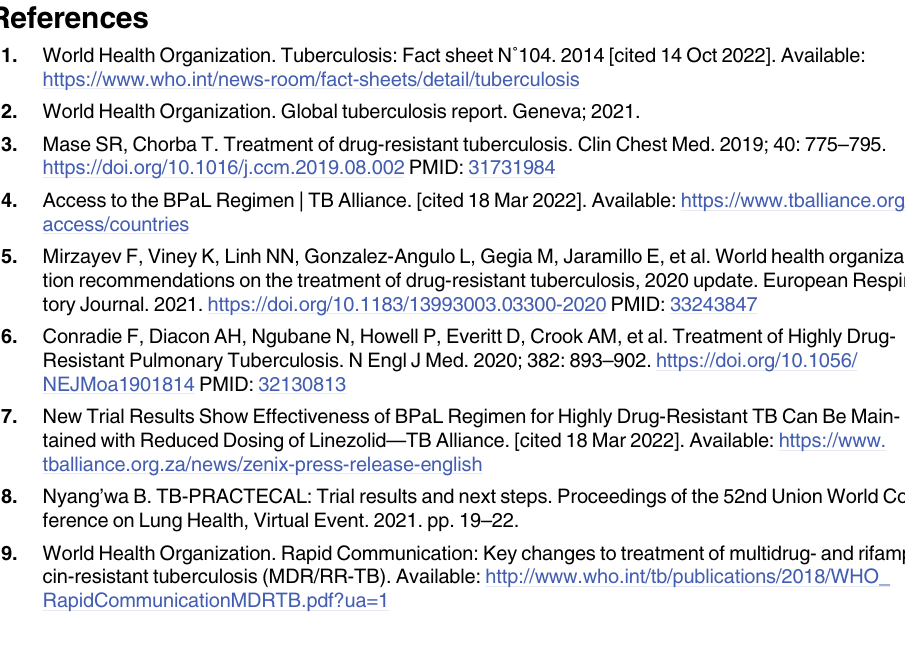
S5 Table. Probabilistic sensitivity analysis